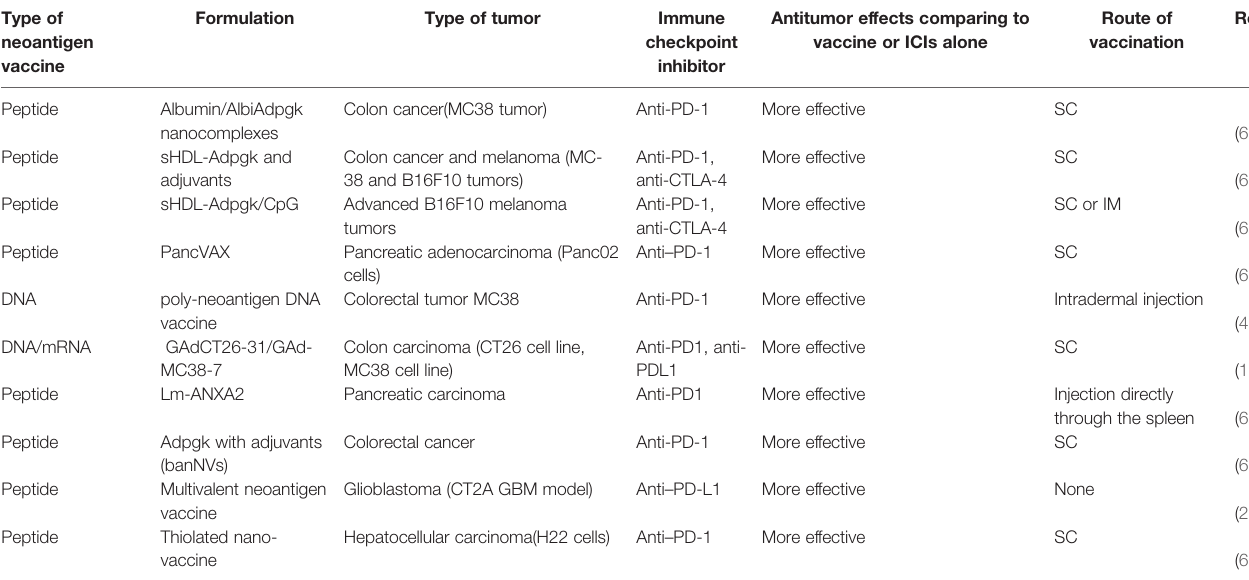
TABLE 1 | Preclinical trials of neoantigen vaccines combined with immune checkpoint